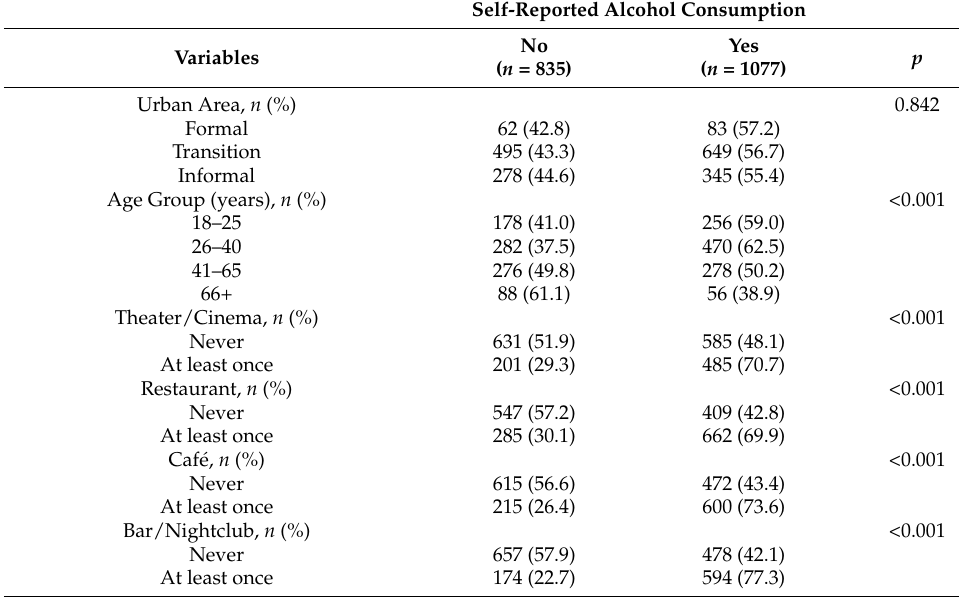
Table A1. Alcohol consumption by urban areas, age group, and recreational